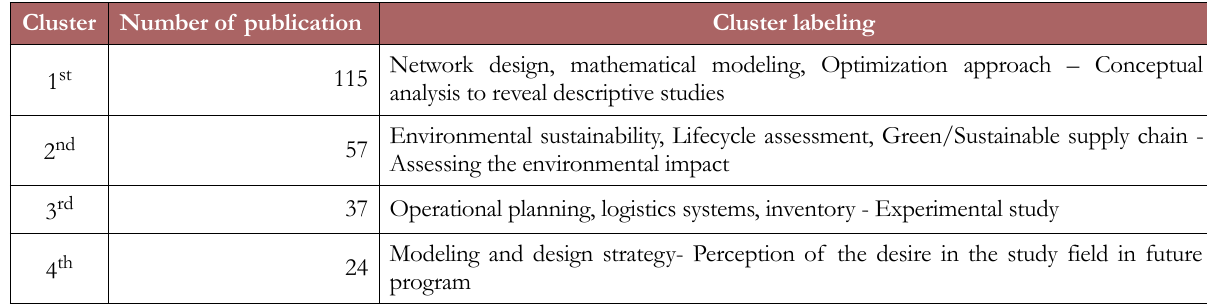
Table 11. The four main clusters and related in our